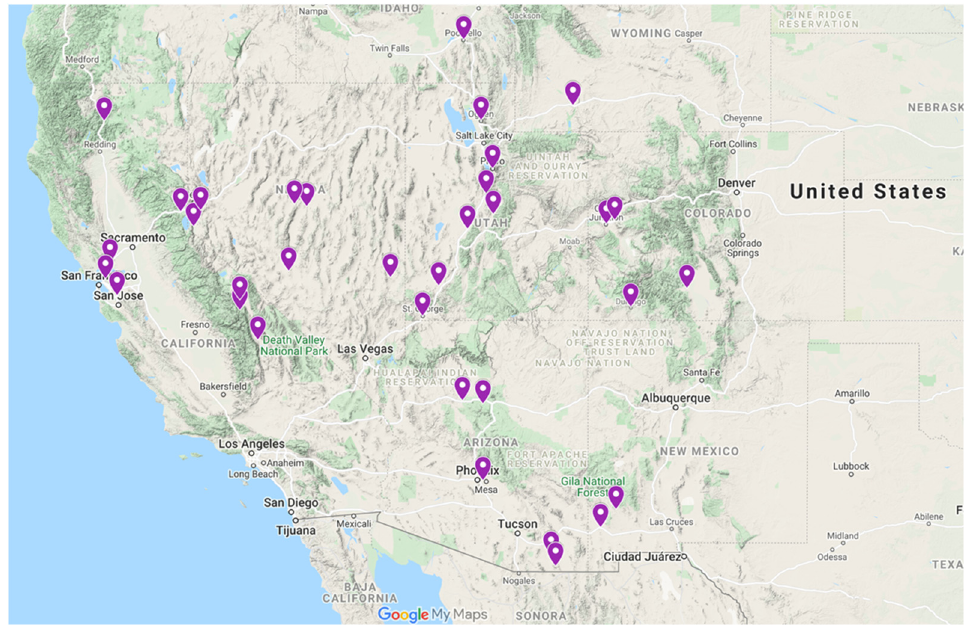
Figure 2. Western Message Petroglyph site distribution. Western Message Petroglyphs are neatly engraved with metal edged tools into rock walls and isolated boulders located in natural landscape settings at 39 known sites (Table